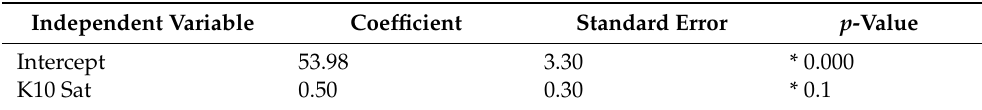
Table 3. Regression results of MASQ Saturday scores (dependent variable) and K10 Saturday scores (independent variable). * p < 0.1.